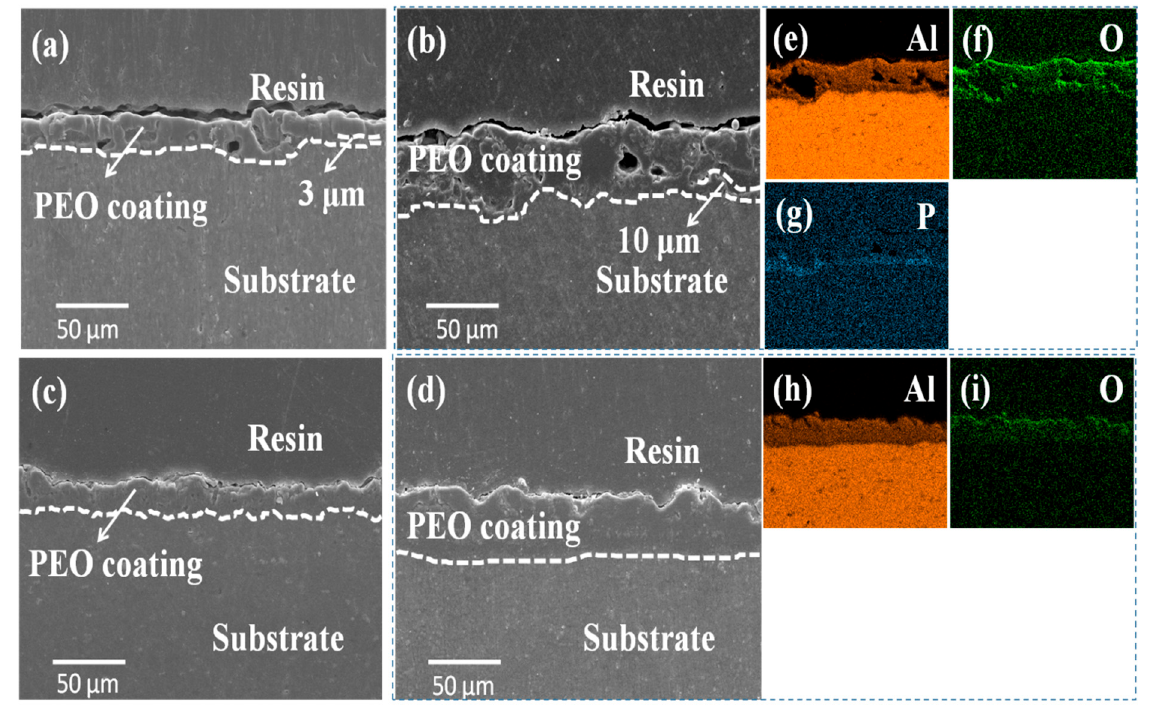
Figure 3. Cross-sectional SEM morphologies of the surface coatings prepared from different electrolytes with different treating time: ( a , b ) P30 and P60 coatings; ( c , d ) Al30 and Al60 coatings; ( e – g ) the EDS elemental mappings of P60 coating; ( h , i ) the EDS elemental mappings of Al60 coating.